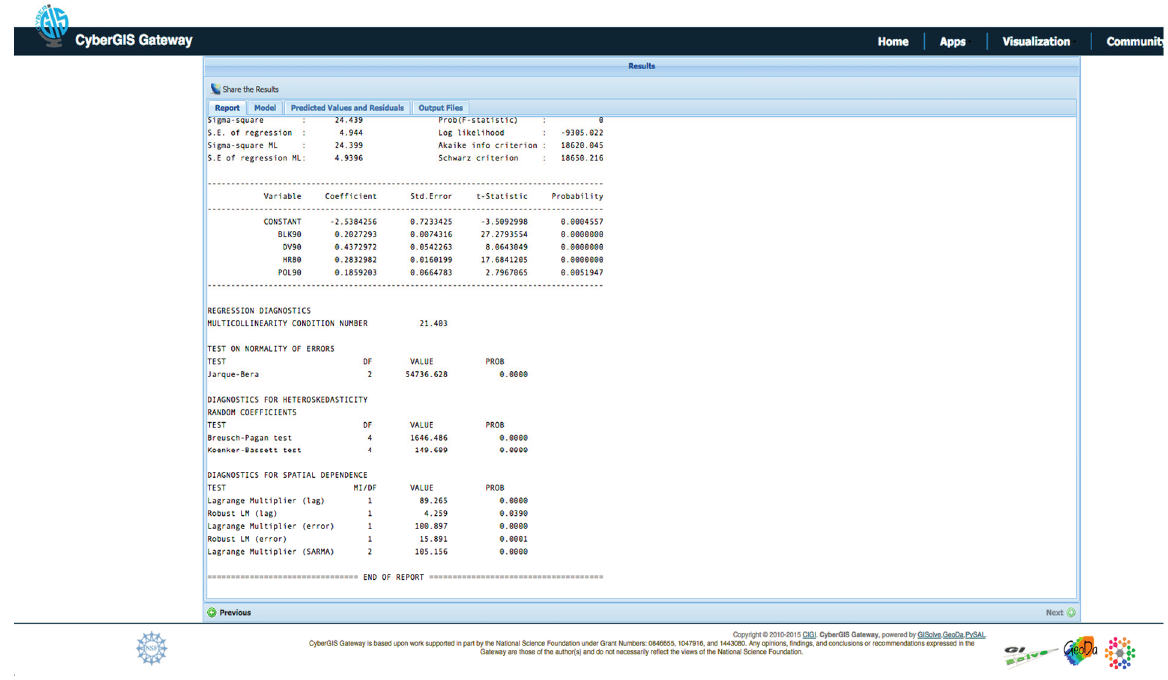
Figure 8. PySAL in the CyberGIS